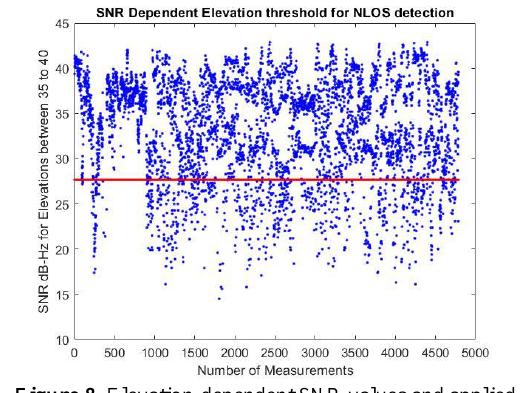
Figure 8. Elevation-dependent SNR values and applied Threshold for 35 ° -40 ° elevation binning (Blue dots are satellites SNRs and red line is SNR threshold in 35 ° -40 ° elevation bin, this threshold is chosen using the average of the SNRs in each height bin minus 10)